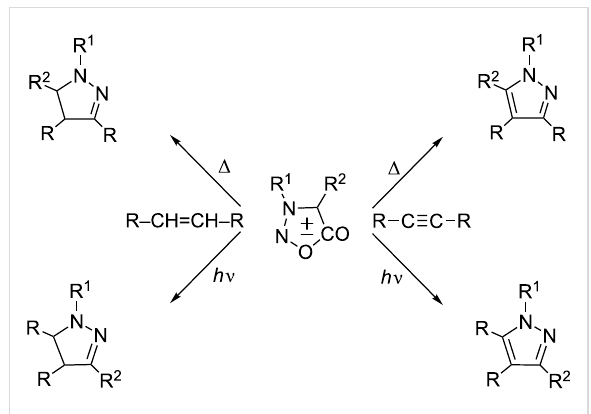
zoline derivatives, depending on the applied dipolarophile (Scheme 1). Namely, sydnones are masked 1,3-dipoles that by photolysis give nitrile imine intermediates, or in thermal reac- tions react as cyclic azomethine imines.